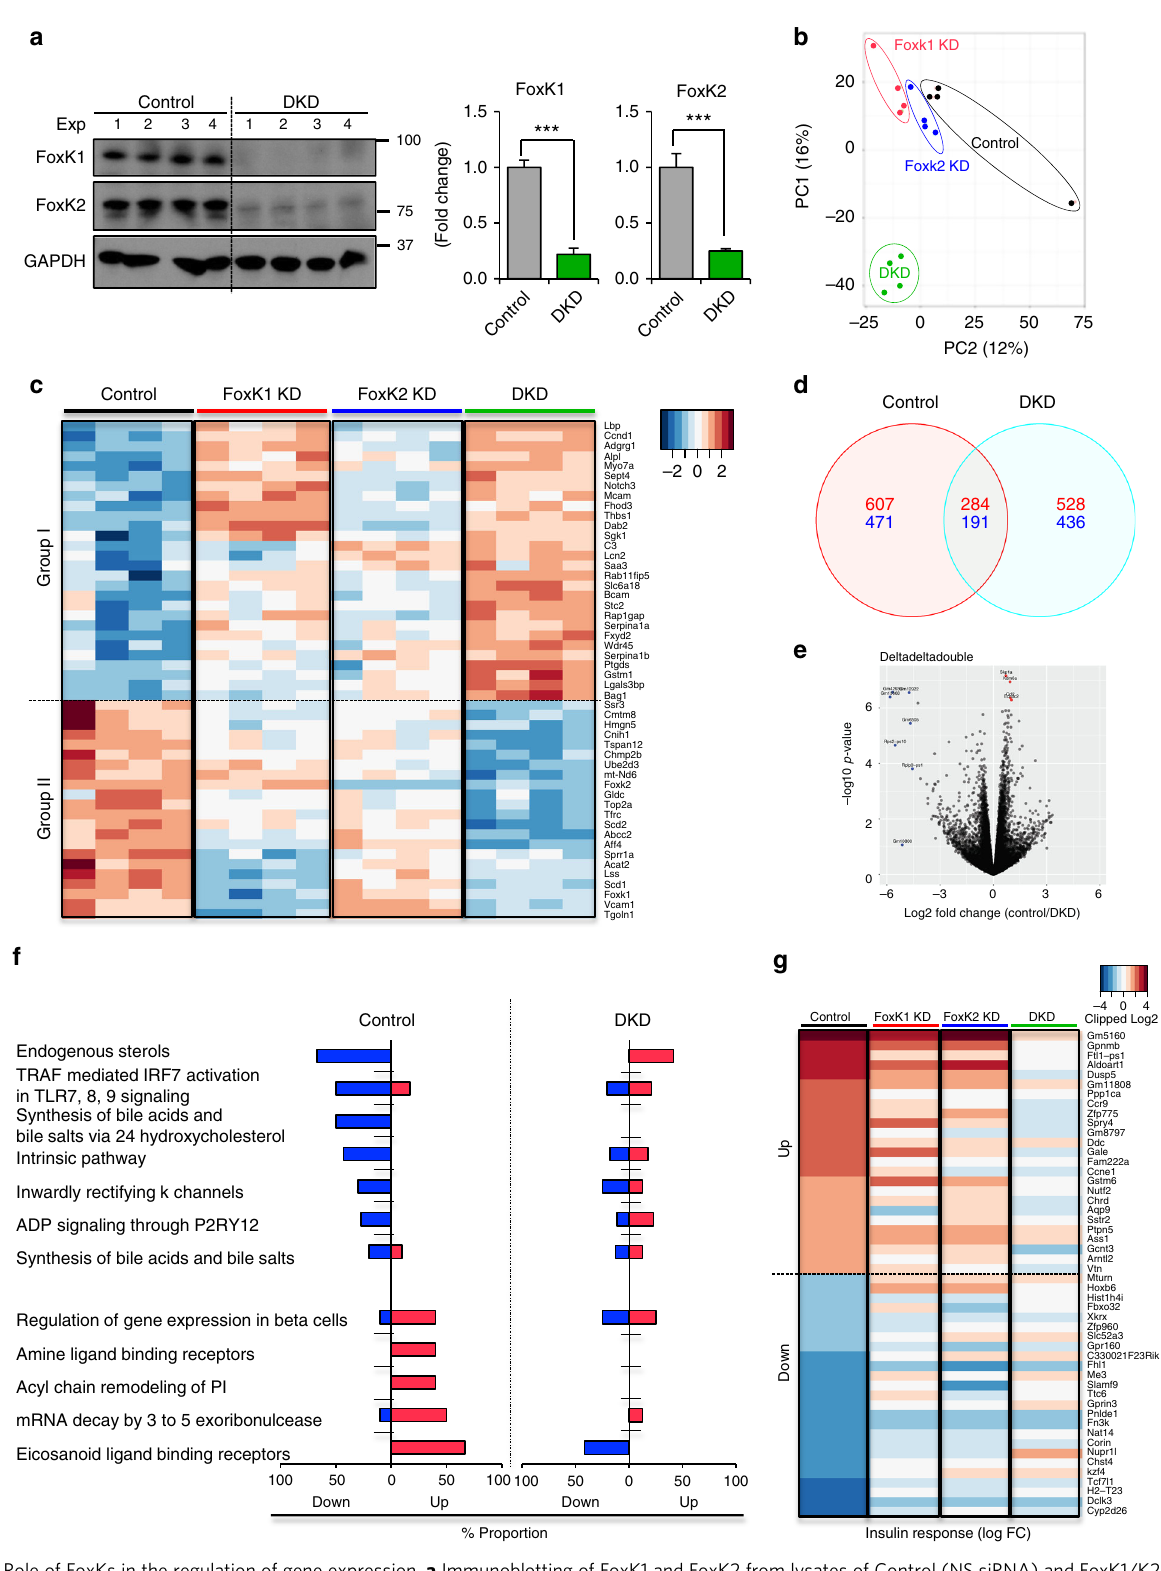
Fig. 5 Role of FoxKs in the regulation of gene expression. a Immunoblotting of FoxK1 and FoxK2 from lysates of Control (NS siRNA) and FoxK1/K2 double knockdown (DKD) cells using siRNAs (two-tailed Student t -test, * P < 0.05; ** P < 0.01; *** P < 0.001) ( n = 4). All data are represented as mean ± SEM. b PCA plots of the transcriptome pro fi les of Control (Black), FoxK1 KD (Red), FoxK2 KD (Blue), and DKD (Green) cells. c Heatmap of top 50 most signi fi cantly changed genes among all groups. d Venn diagram showing the numbers of signi fi cantly regulated genes by insulin in Control and DKD cells (FDR < 0.25). e Volcano plot showing the distribution of differentially regulated genes by insulin stimulation with log-fold change in Control versus DKD fold change on X -axis and − log10 P value on Y -axis. f Top directionally regulated reactome pathways by insulin in Control but not DKD cells. g Heatmap of top 50 (up and down: each top 25 for each) differentially regulated by insulin in Control and DKD